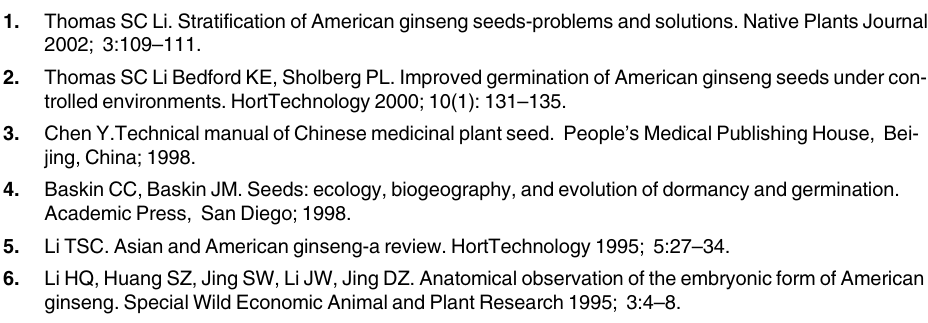
S1 Table. Primers used in the semi-quantitative PCR analysis of 30 selected unigenes. S2 Table. Selected unique transcripts that might be related with seed dormancy release or seed development. S3 Table. KEGG categories of non-redundant unigenes in the American ginseng seedsli- braries. S4 Table. Enriched GO annotations of differentially expressed genes during the American Ginseng seed dormancy release. S5 Table. Enriched KEGG pathways of differentially expressed genes during seed dormancy